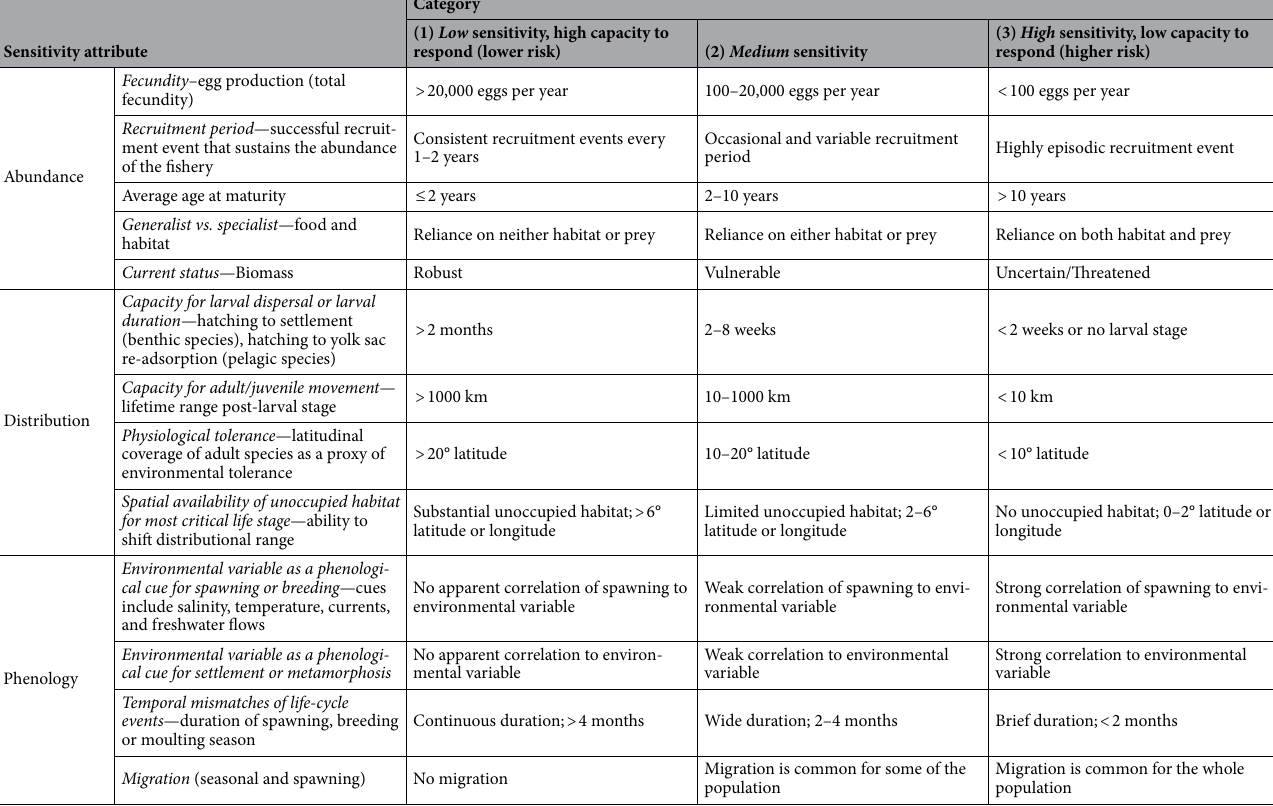
Table 2. Sensitivity attributes, categories and criteria used to assess the relative sensitivity of key fishery resources to climate change in the Northern Humboldt Current System, adapted from a previous study 35